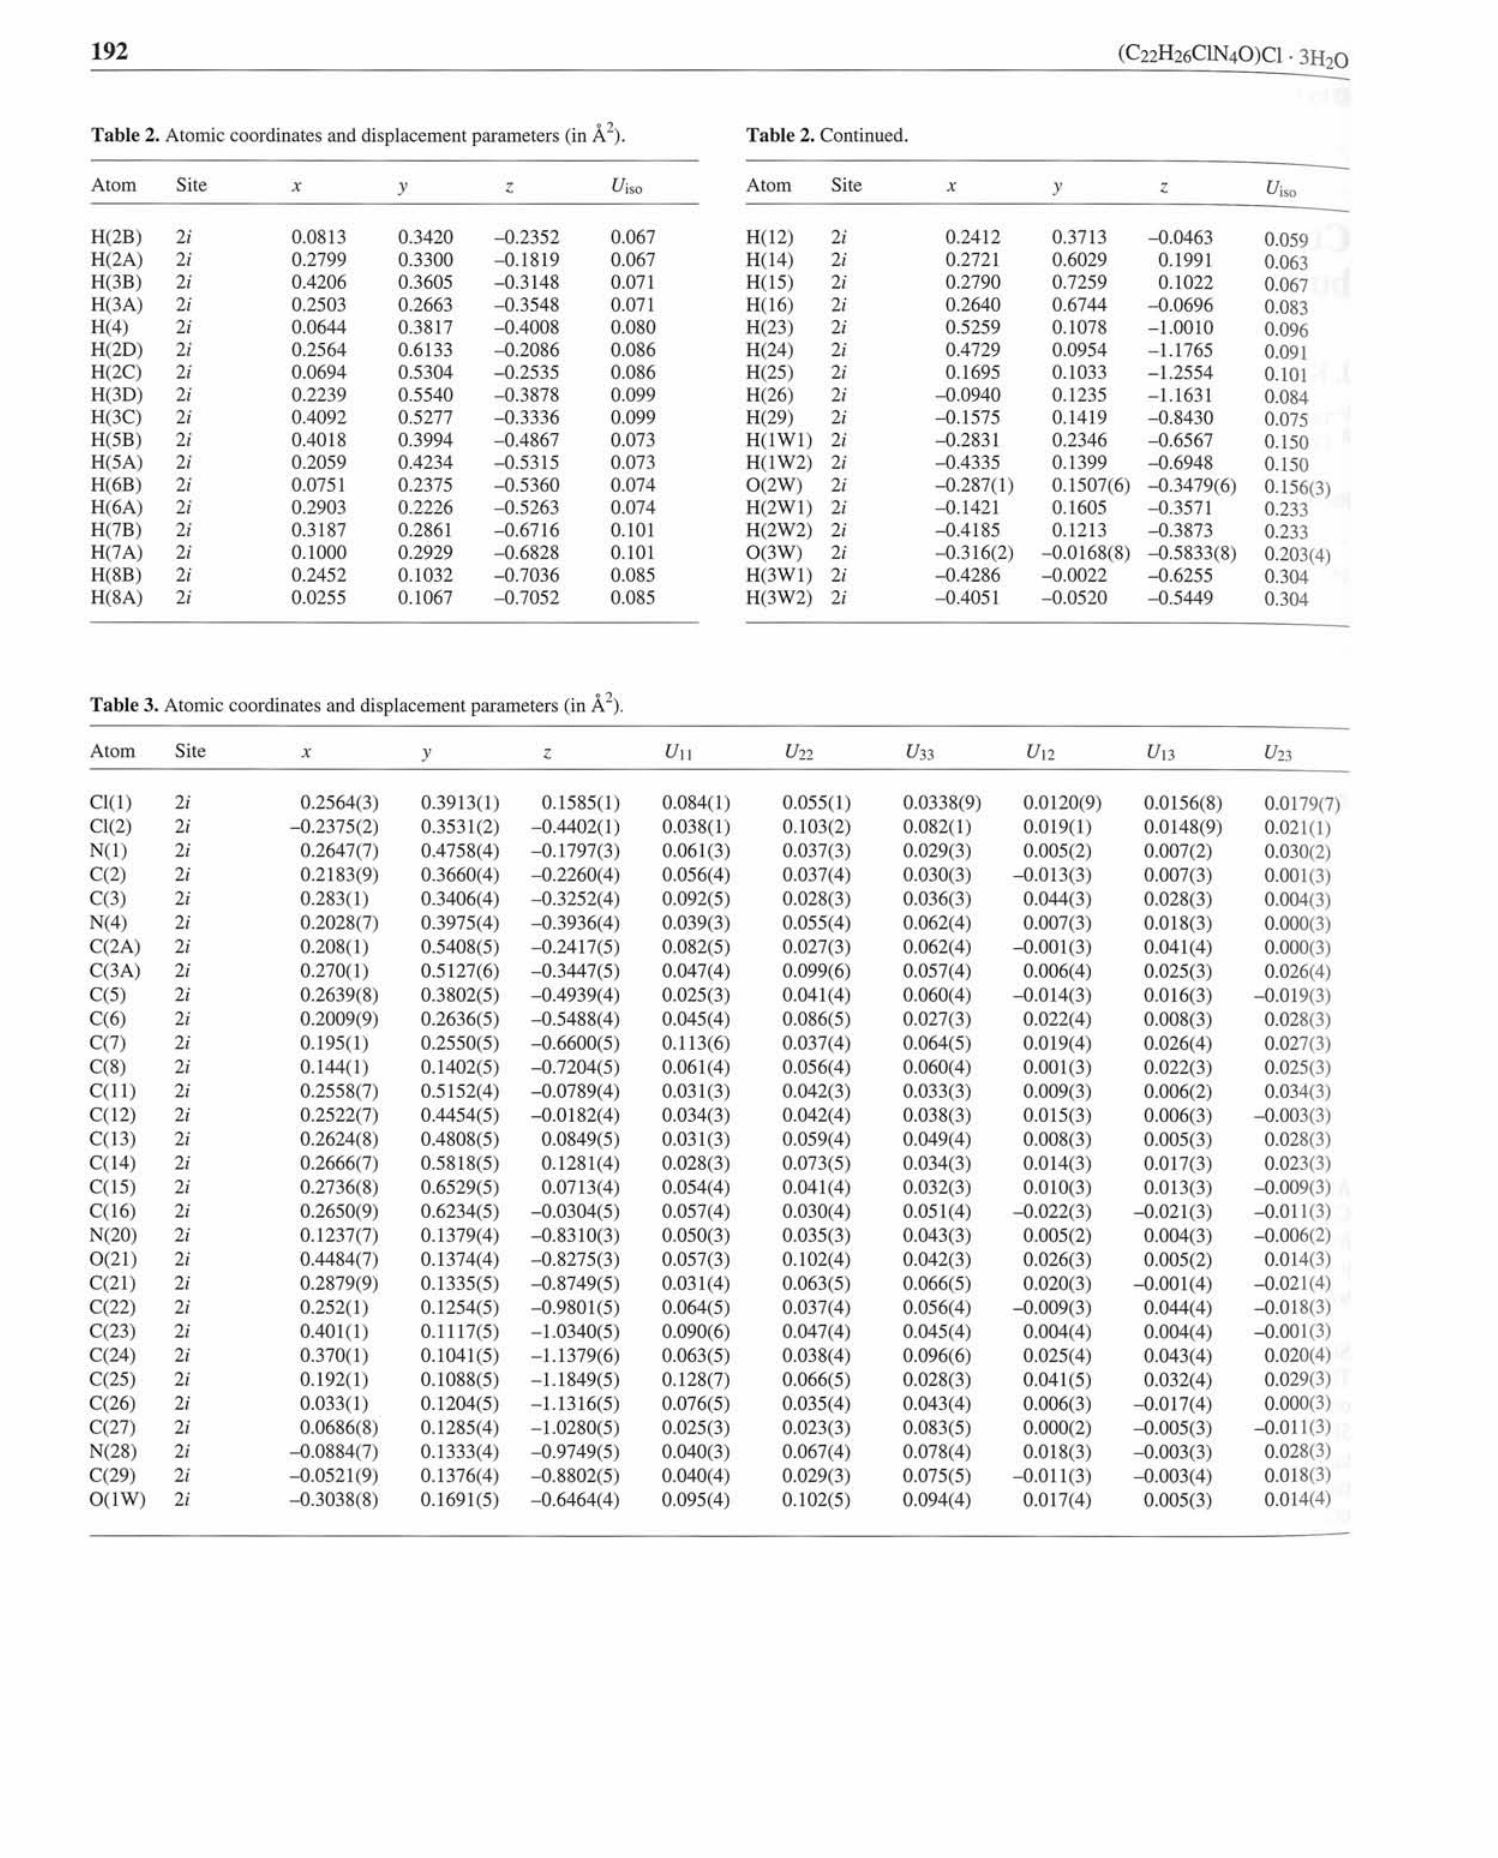
Table 3. Atomic coordinates and displacement parameters (in Â 2